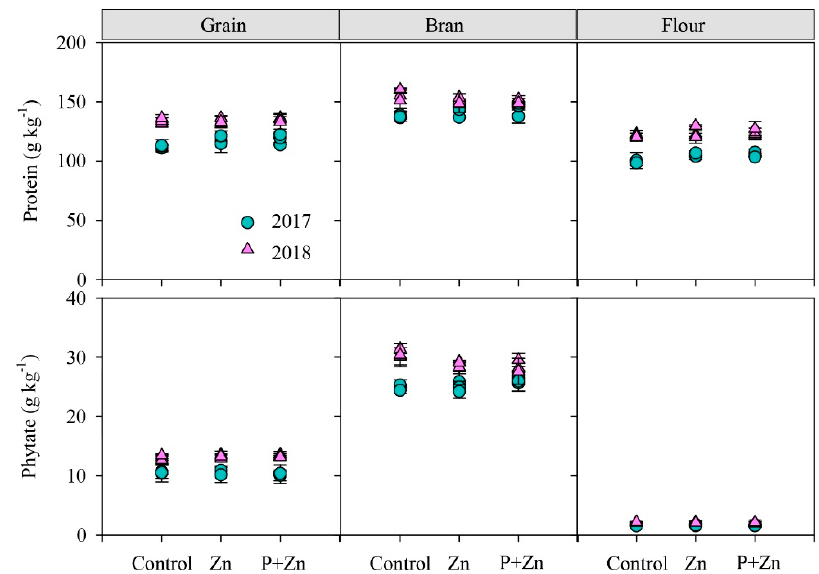
Figure 5. The protein and phytate concentrations in grain, bran, and flour in wheat with nil Zn spray (control) and foliar Zn application alone (Zn) or plus pesticides (P+Zn) in 2017 and 2018. Vertical bars represent the standard error of four replications.